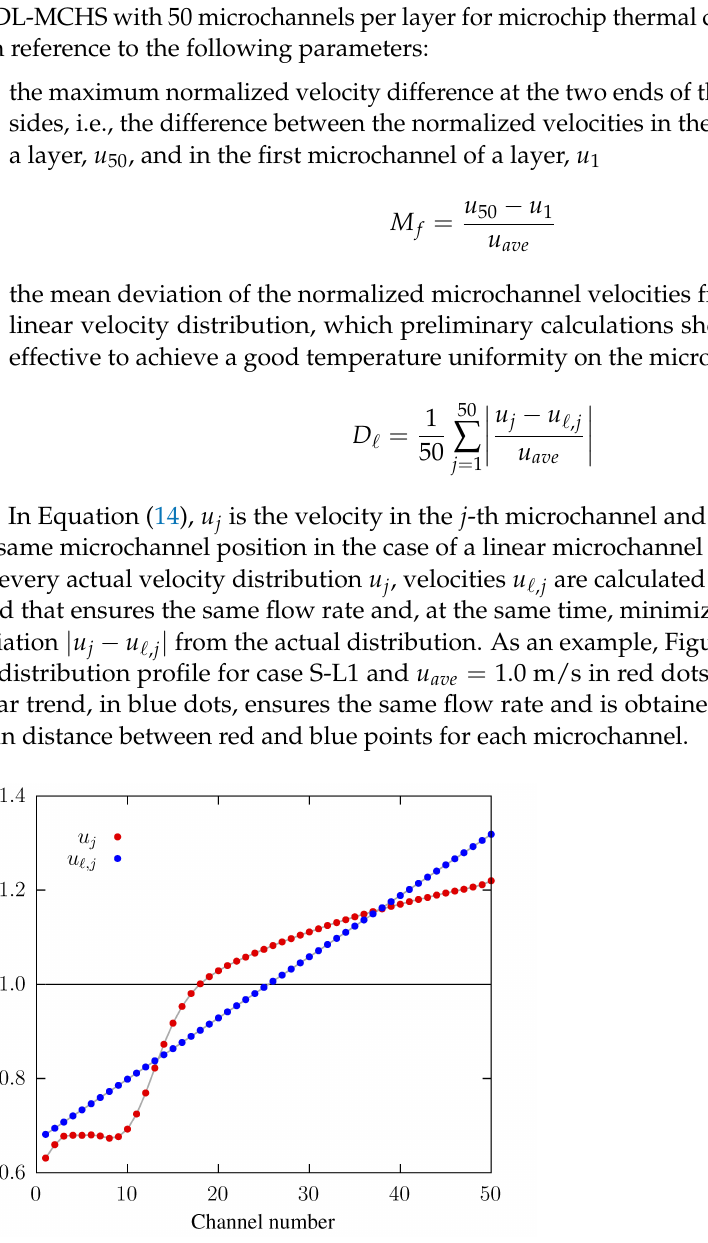
Figure 12. Velocity distribution u j and corresponding linear velocity distribution u (cid:96) , j for case S-L1 and u ave = 1.0